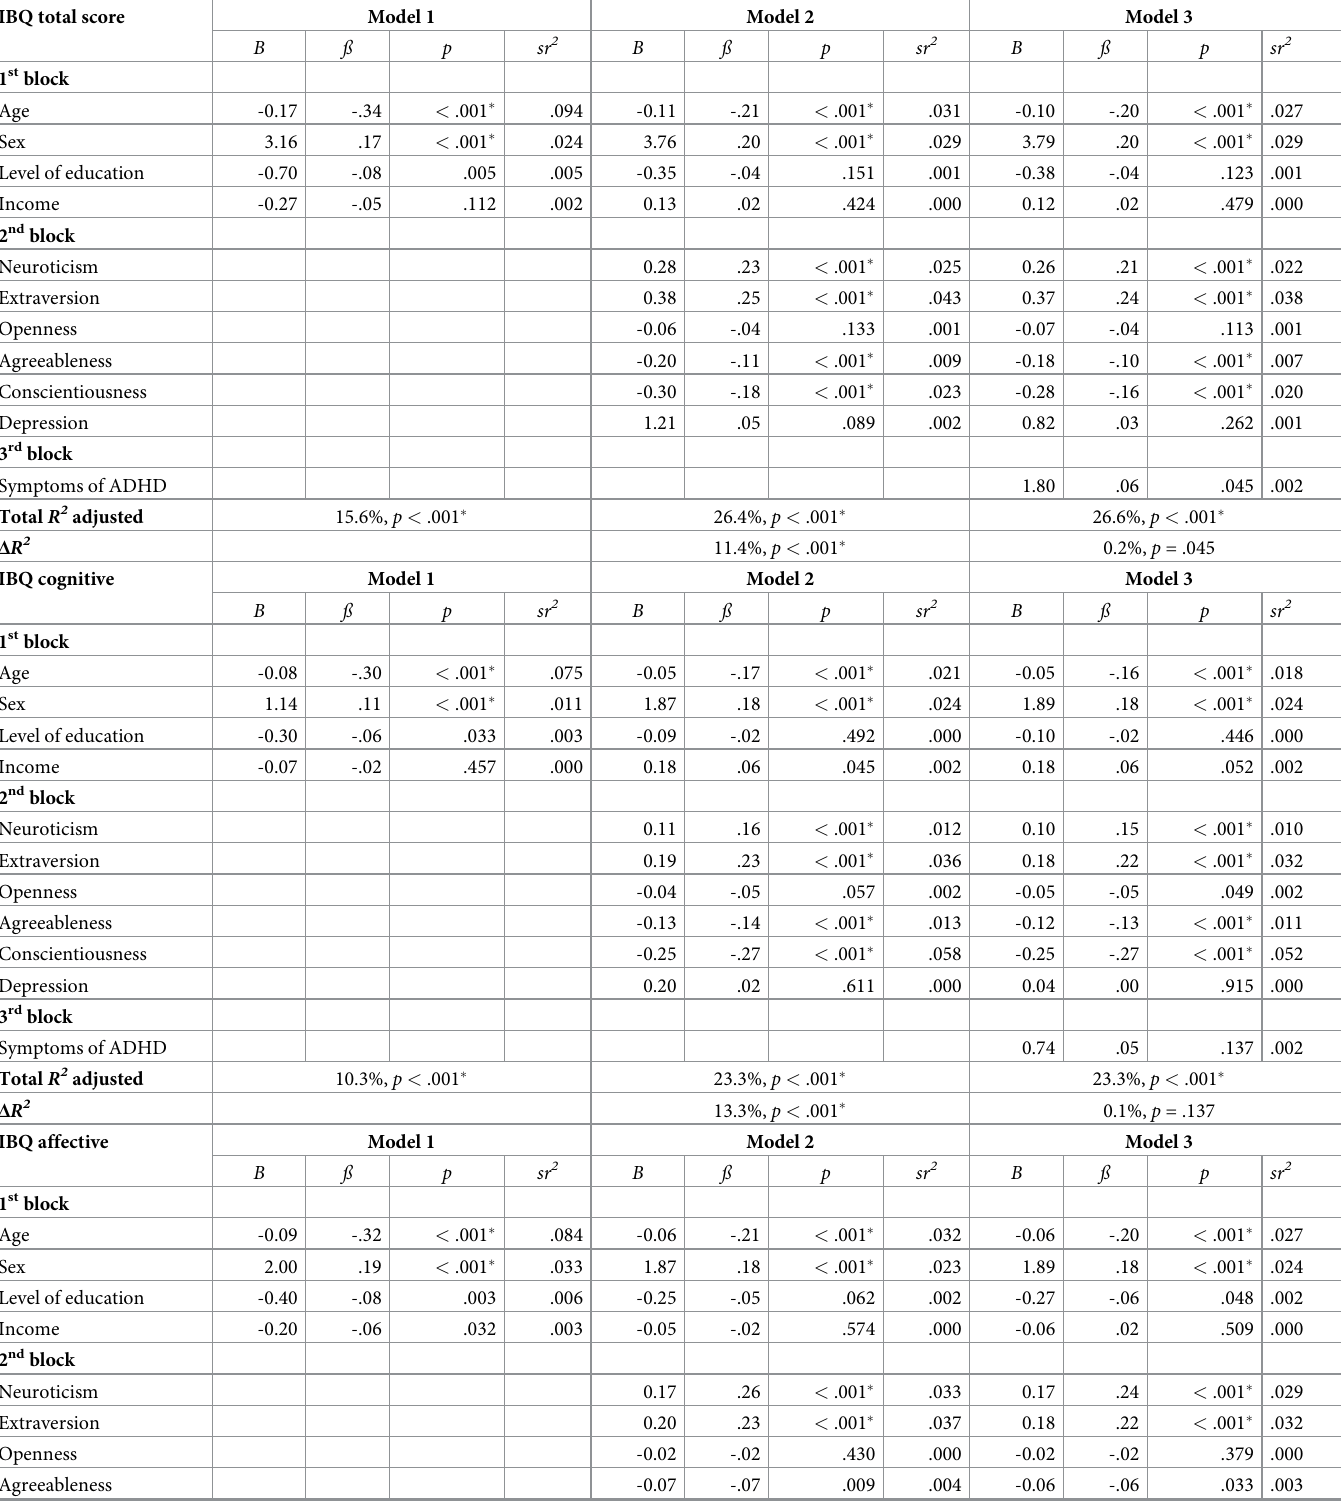
Table 4. Hierarchical regressions of impulsive buying behavior in the total